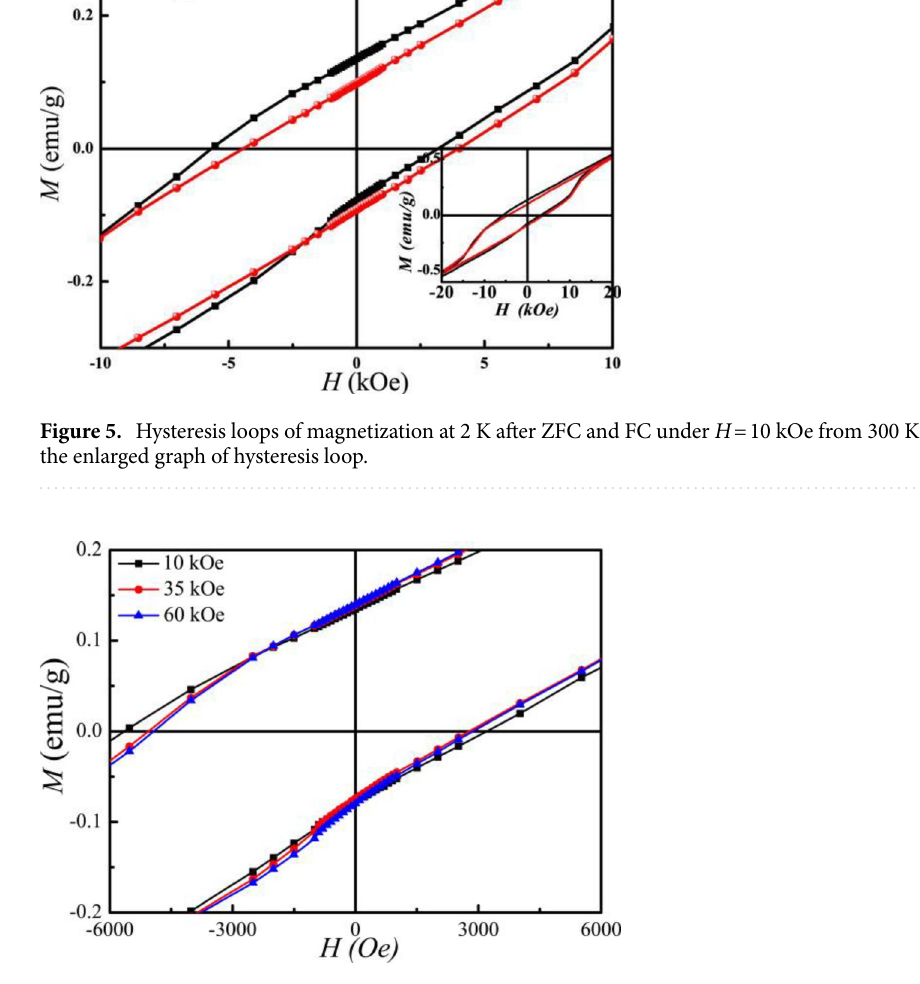
Figure 6. Hysteresis loops of magnetization at 2 K after FC under H = 10 kOe, 35 kOe and 60